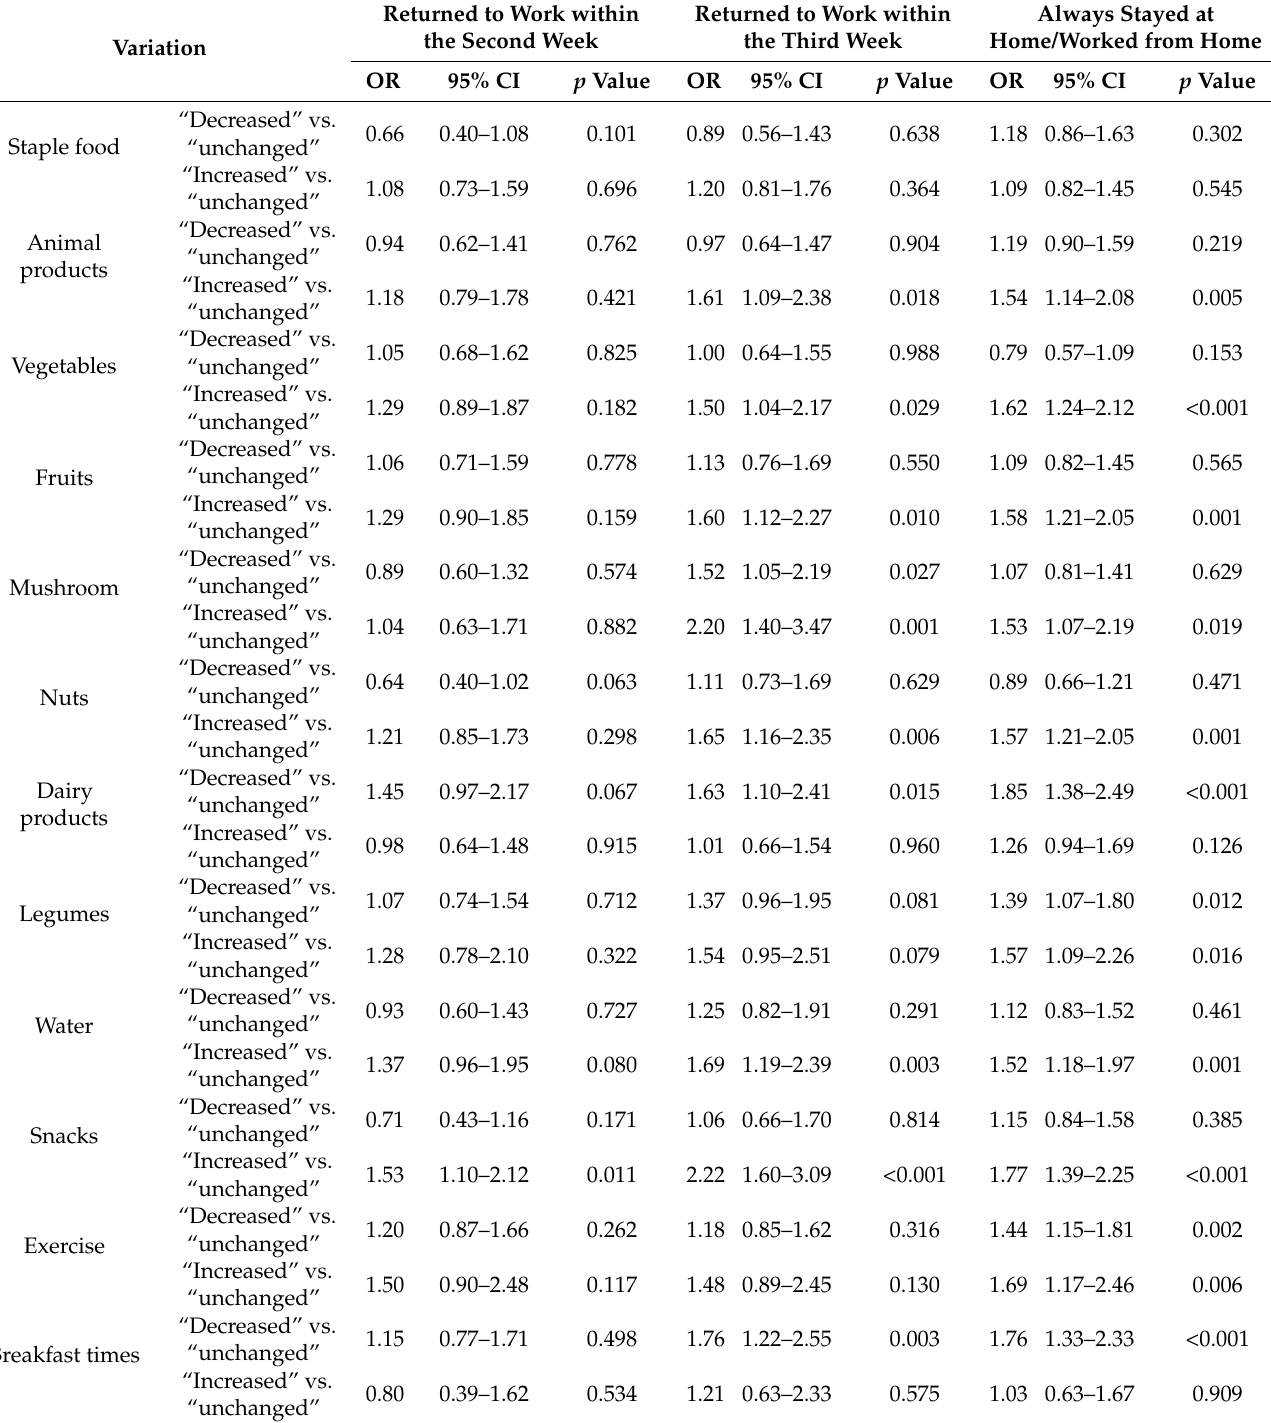
Table 6. Multinomial logistic regression of status during lockdown on changes in eating habits and lifestyles 1